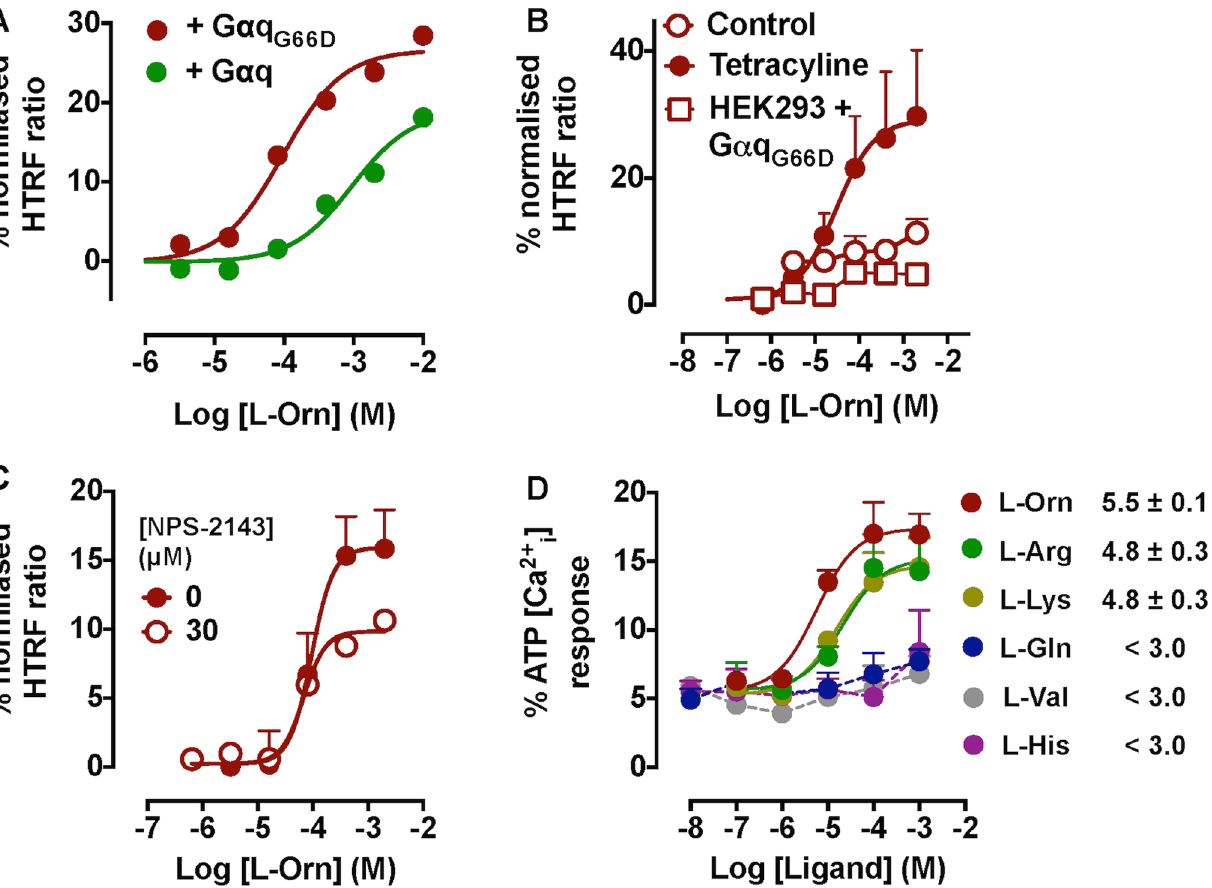
Fig 1. Calcium mobilisation and inositol phosphate accumulation in FlpIn-TREx-HEK293-mGPRC6A cells. (A) Inositol phosphate accumulation responses to L-ornithine in FlpIn-TREx-HEK293-mGPRC6A cells with co-expression of G α q or G α qG66D . (B) The L-ornithine response is specific to FlpIn- TREx-HEK293 cells (co-expressing G α qG66D ) induced to express mGPRC6A with tetracycline, but absent in non-tetracycline induced or parental HEK293 cells. (C) GPRC6A-mediated inositol phosphate accumulation can be inhibited with the antagonist, NPS-2143 (30 μ M). (D) Ca 2+ mobilisation induced by various L-amino acids in FlpIn-TREx-HEK293-mGPRC6A cells co-expressing G α qG66D . The rank order of potency is L-ornithine > L-arginine = L-lysine (values quoted represent pEC 50 ± SEM). Similar responses were observed with G α q co-expression ( data not shown ).